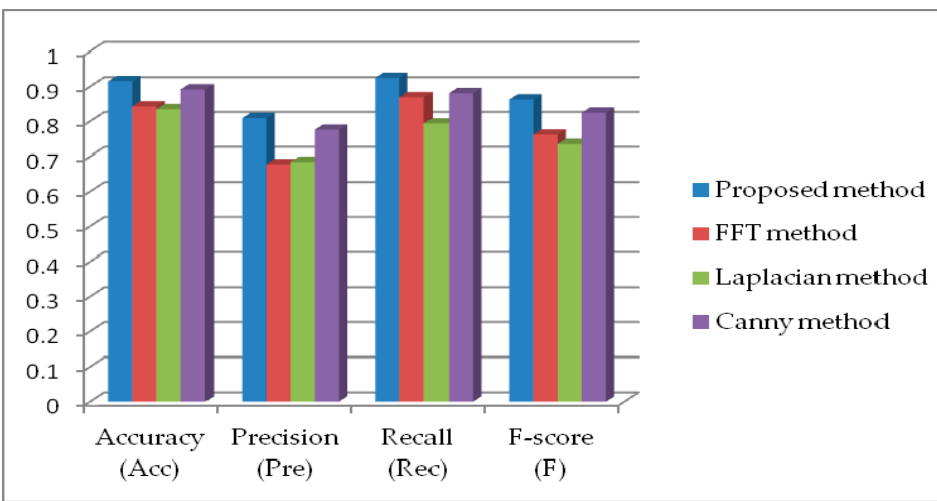
Figure 7. Quantitative comparison of different blur detection approaches.